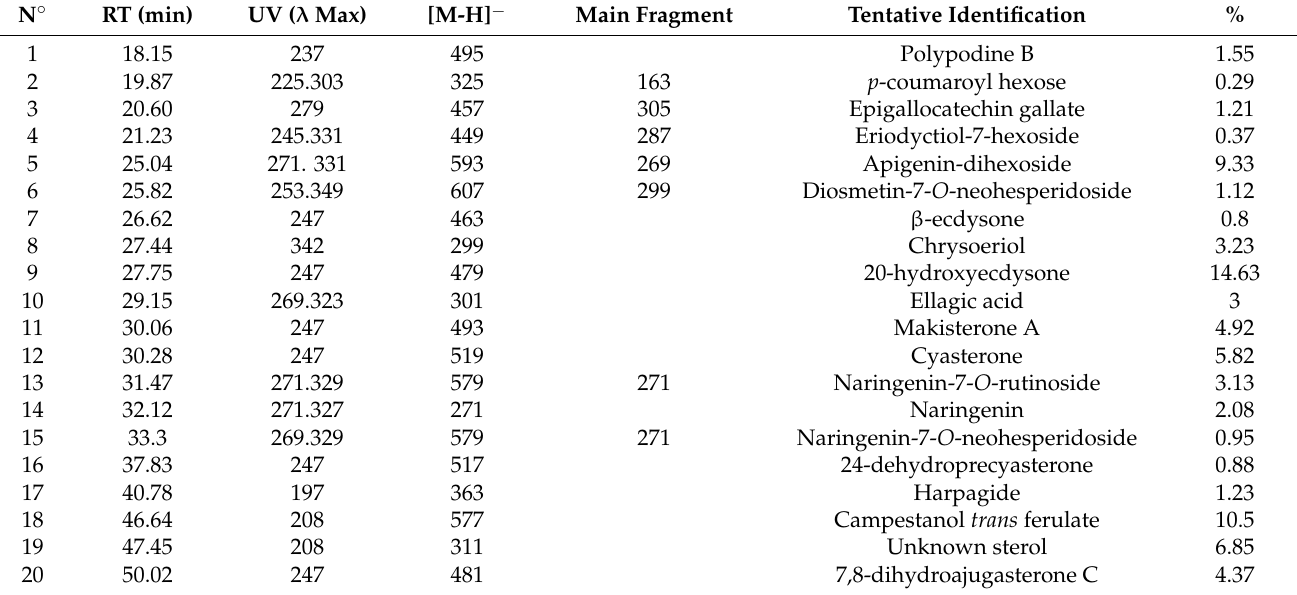
Table 6. Retention time, maximum (RT), UV absorption ( λ max ), mass spectral data, and tentative identification of the phenolic compounds in the methanol extract of A. iva leaves (n = 3 samples, 3 replicates per